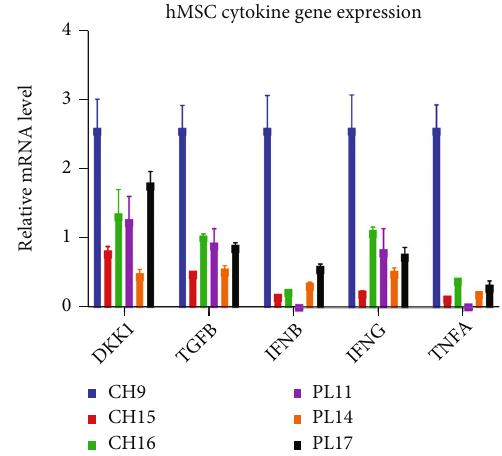
Figure 2: The expression levels of cytokine genes in CH-hMSCs and PL-hMSCs. The expression levels of the cytokine genes were determined by qRT-PCR and standardized with the expression level of GAPDH of the same sample. CH-hMSCs were derived from 3 donors (CH9, CH15, and CH16) and PL-hMSCs were derived from 3 donors (PL11, PL14, and PL17). Data are presented as mean ± SEM of three experiments. Abbreviations: DKK1: dickkopf WNT signaling pathway inhibitor 1, TGF- β